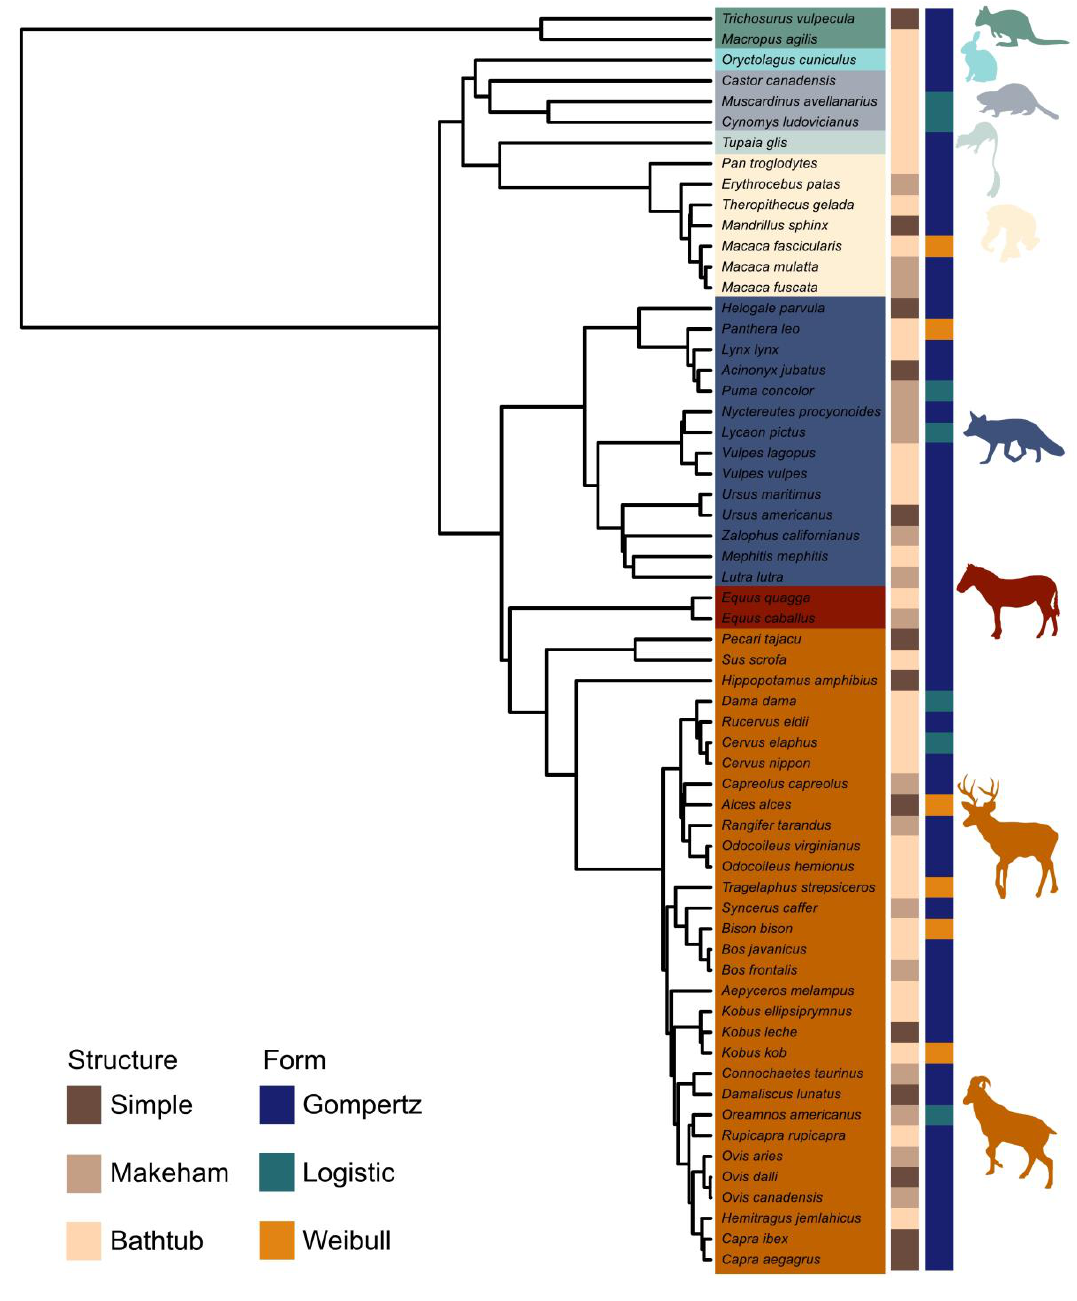
Figure 2 . Phylogenetic tree representing the diversity of structure and form of actuarial senescence across 61 species of mammals.